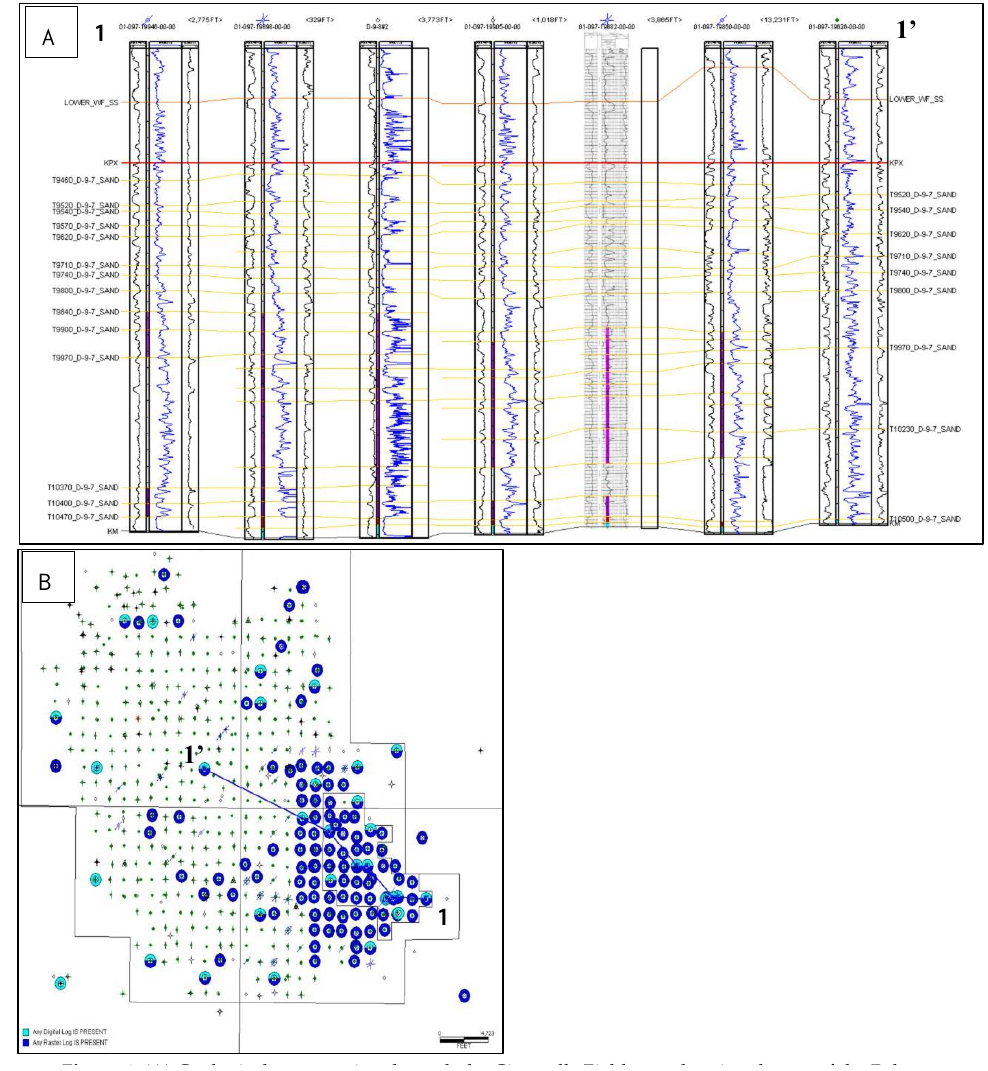
Figure 4. (A) Geological cross section through the Citronelle Field area showing the top of the Paluxy Formation (KPX) and the individual sand intervals of the Paluxy (T9460 through T10470) interpreted within the formation from vintage well logs. The log tracks from left to right are spontaneous potential (SP), induction (ILD), and short normal (SN). The cross section has been flattened to the top of the Paluxy Formation. (B) Map of the Citronelle Field area and the corresponding cross section line. Source: Author Conception. Cross section and map created in Petra ®